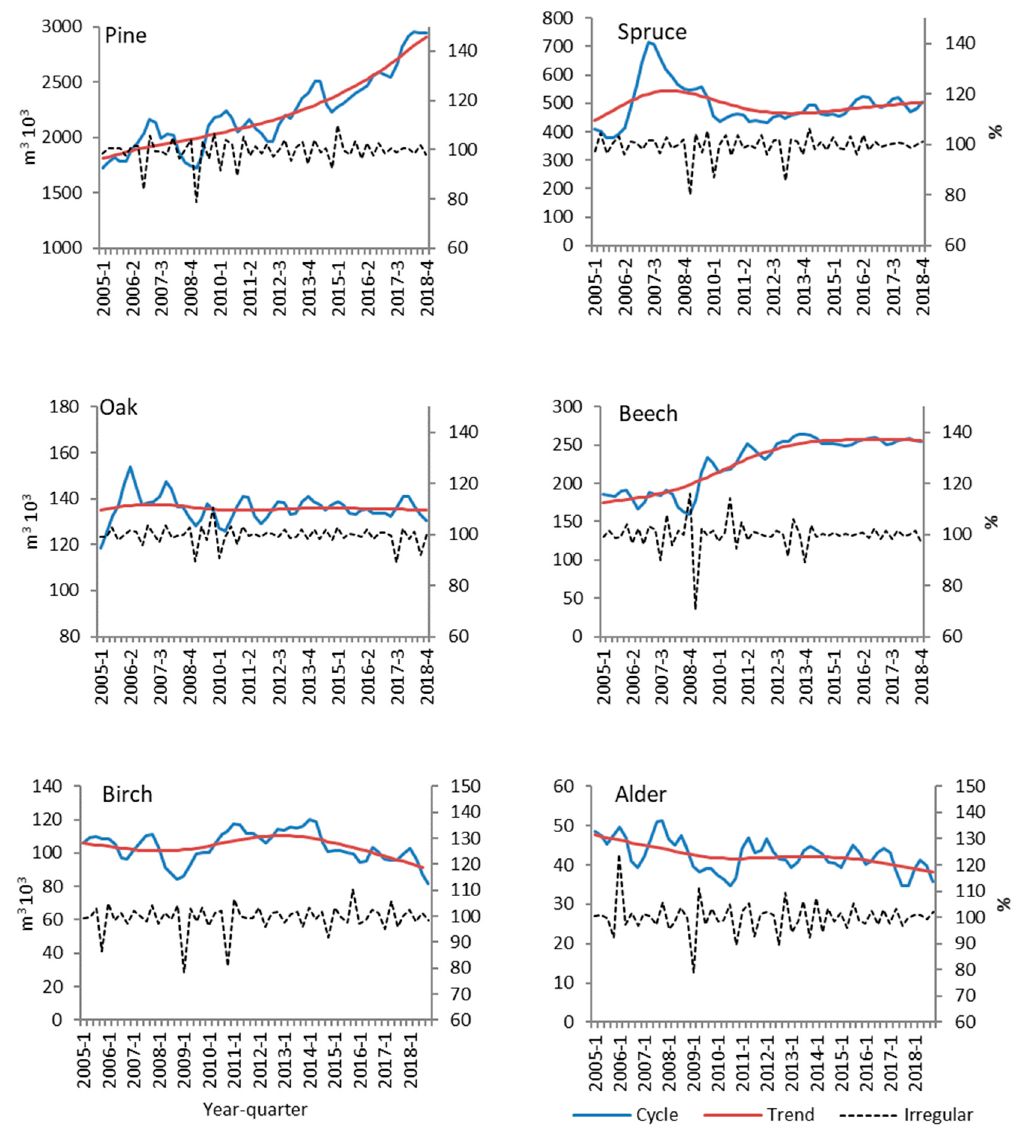
Figure 5. Irregular and cyclical fluctuations and long-term trends in sawtimber supply in Poland in the years 2005–2018.